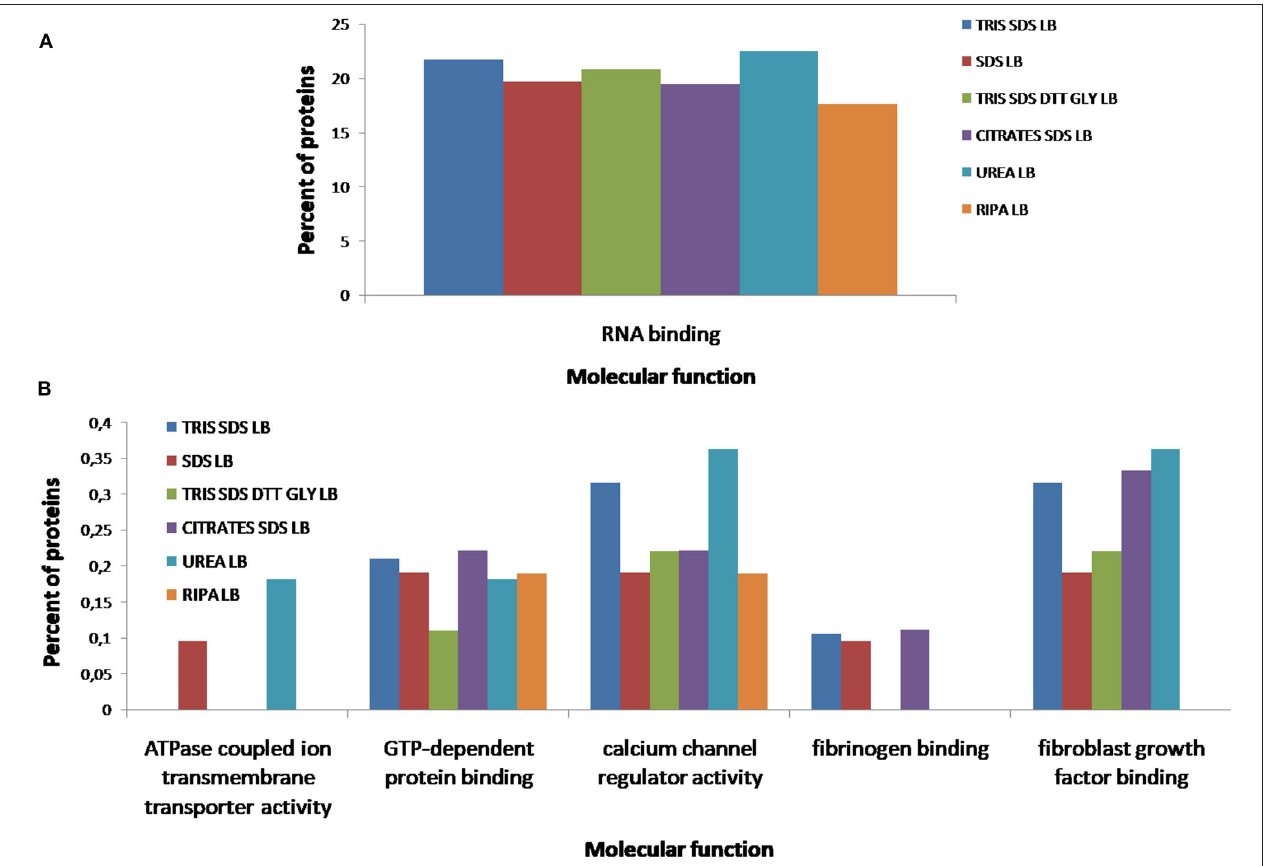
FIGURE 10 | Functional classification of all proteins identified after the extraction with the six different buffers [ buffer 1 (Tris-SDS LB), n = 979 proteins; buffer 2 (urea LB), n = 569 proteins; buffer 3 (Tris-SDS-DTT-Glycerol LB), n = 930 proteins; buffer 4 (citrate-SDS LB), n = 921 proteins; buffer 5 (SDS-LB), n = 1,086 proteins; buffer 6 (RIPA LB), n = 540 proteins], according to their molecular function: (A) RNA binding, (B) ATPase coupled ion transmembrane transporter activity, GTP-dependent protein binding, calcium channel regulator activity, fibrinogen binding, fibroblast growth factor binding, using the FunRich